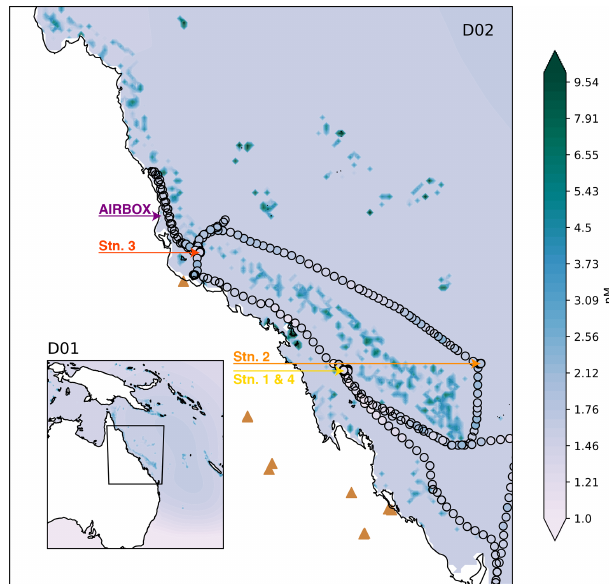
Figure 1. Domain two (D02) of the WRF-Chem simulations, with the outer domain (D01) inset. The colours represent the DMS sur- face water concentrations for the simulations including coral-reef- derived DMS (note the log scale). The RVI ship track is shown by black outlined circles, also coloured by DMS observations. The lo- cations of the RVI stations and AIRBOX are shown by coloured text and arrows. The brown triangles indicate where fossil fuel or biomass burning power generators are